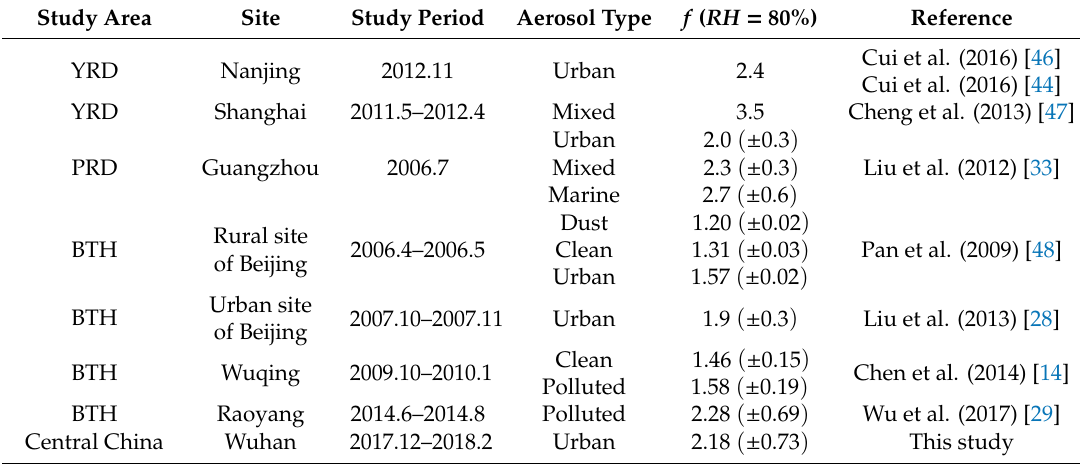
Table 2. Summary of scattering hygroscopic growth factors at RH = 80% in di ff erent regions. Study